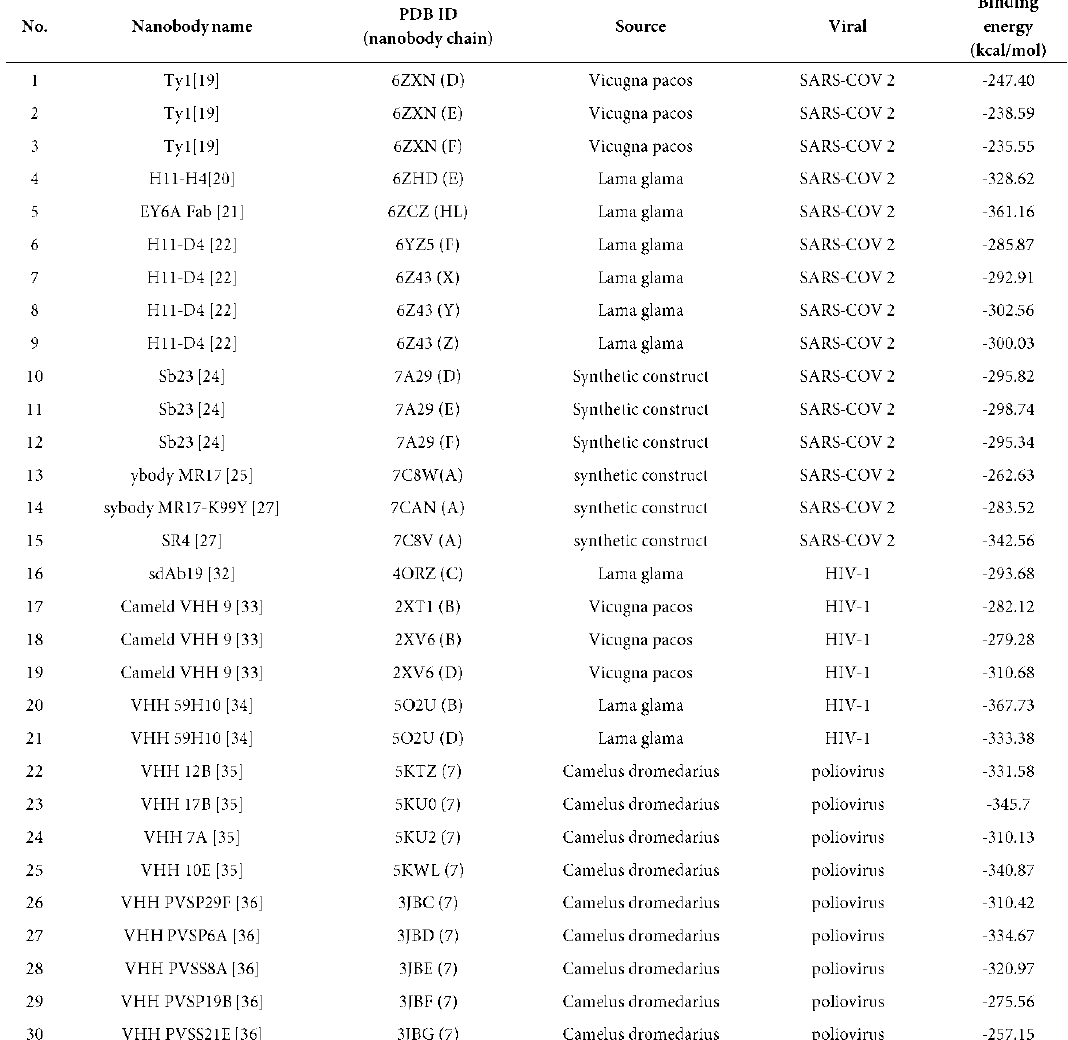
Table 1. The name , PDB ID and source of nanobodies that experimentally was involved against SARS-COV 2 and HIV-1 or poliovirus viral and their predicted binding energy with RBD of SARS-COV